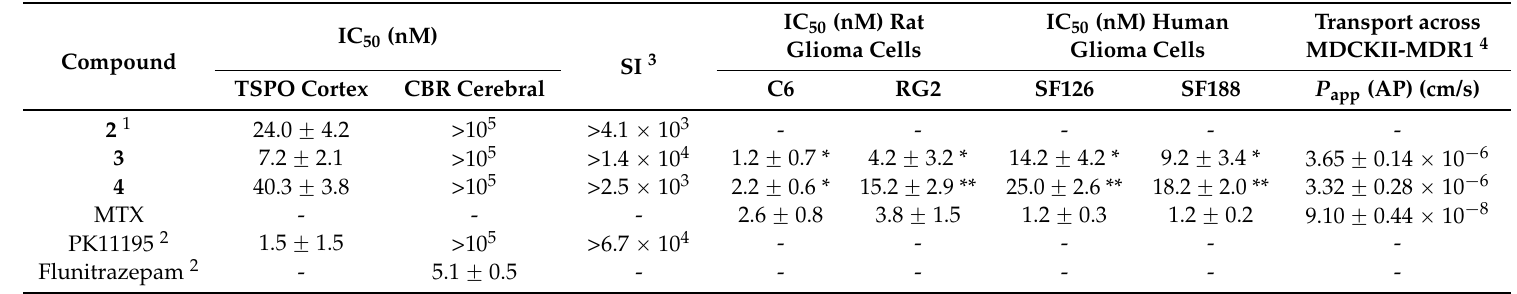
Values are means ˘ SEM of three experiments performed in duplicate; 1 According to [18]; 2 According to [5]; 3 SI: selectivity index; 4 Values are means ˘ SEM of three experiments performed in triplicate. The statistical differences between TSPO ligand-MTX conjugates 3 and 4 , with respect to MTX was calculated by two-way ANOVA followed by